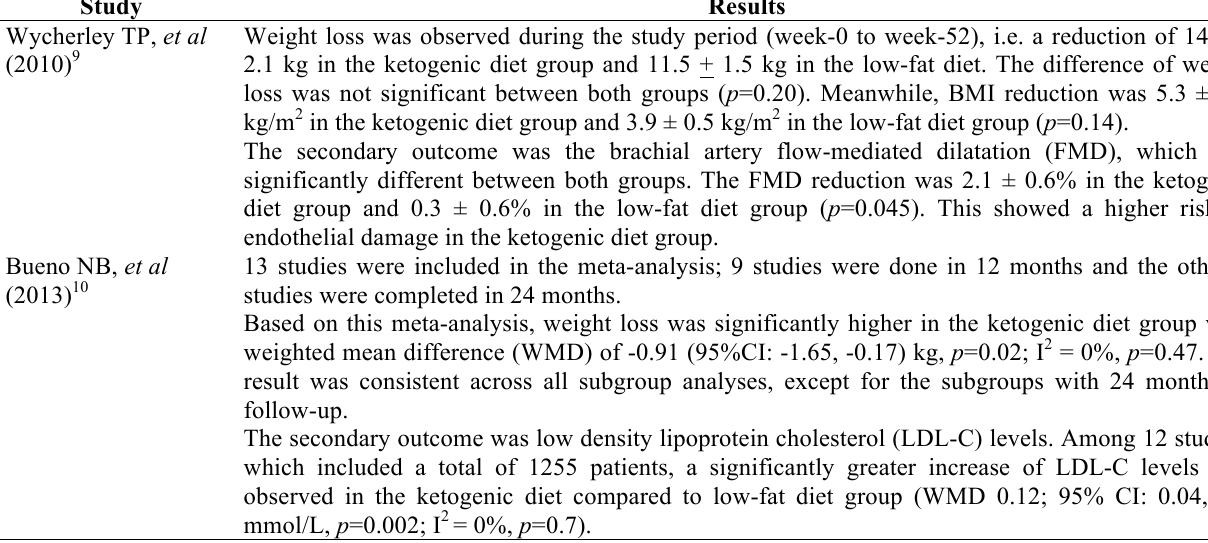
Table 5. Critical appraisal of the importance aspect of each study